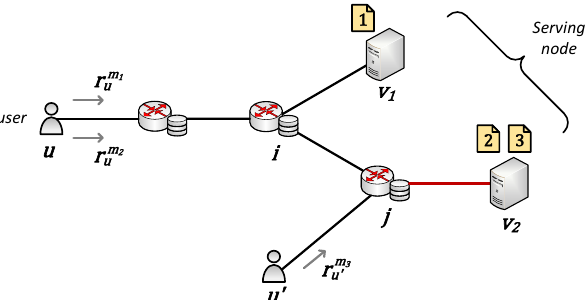
Figure 3. Example of caching content with different transmission distances.